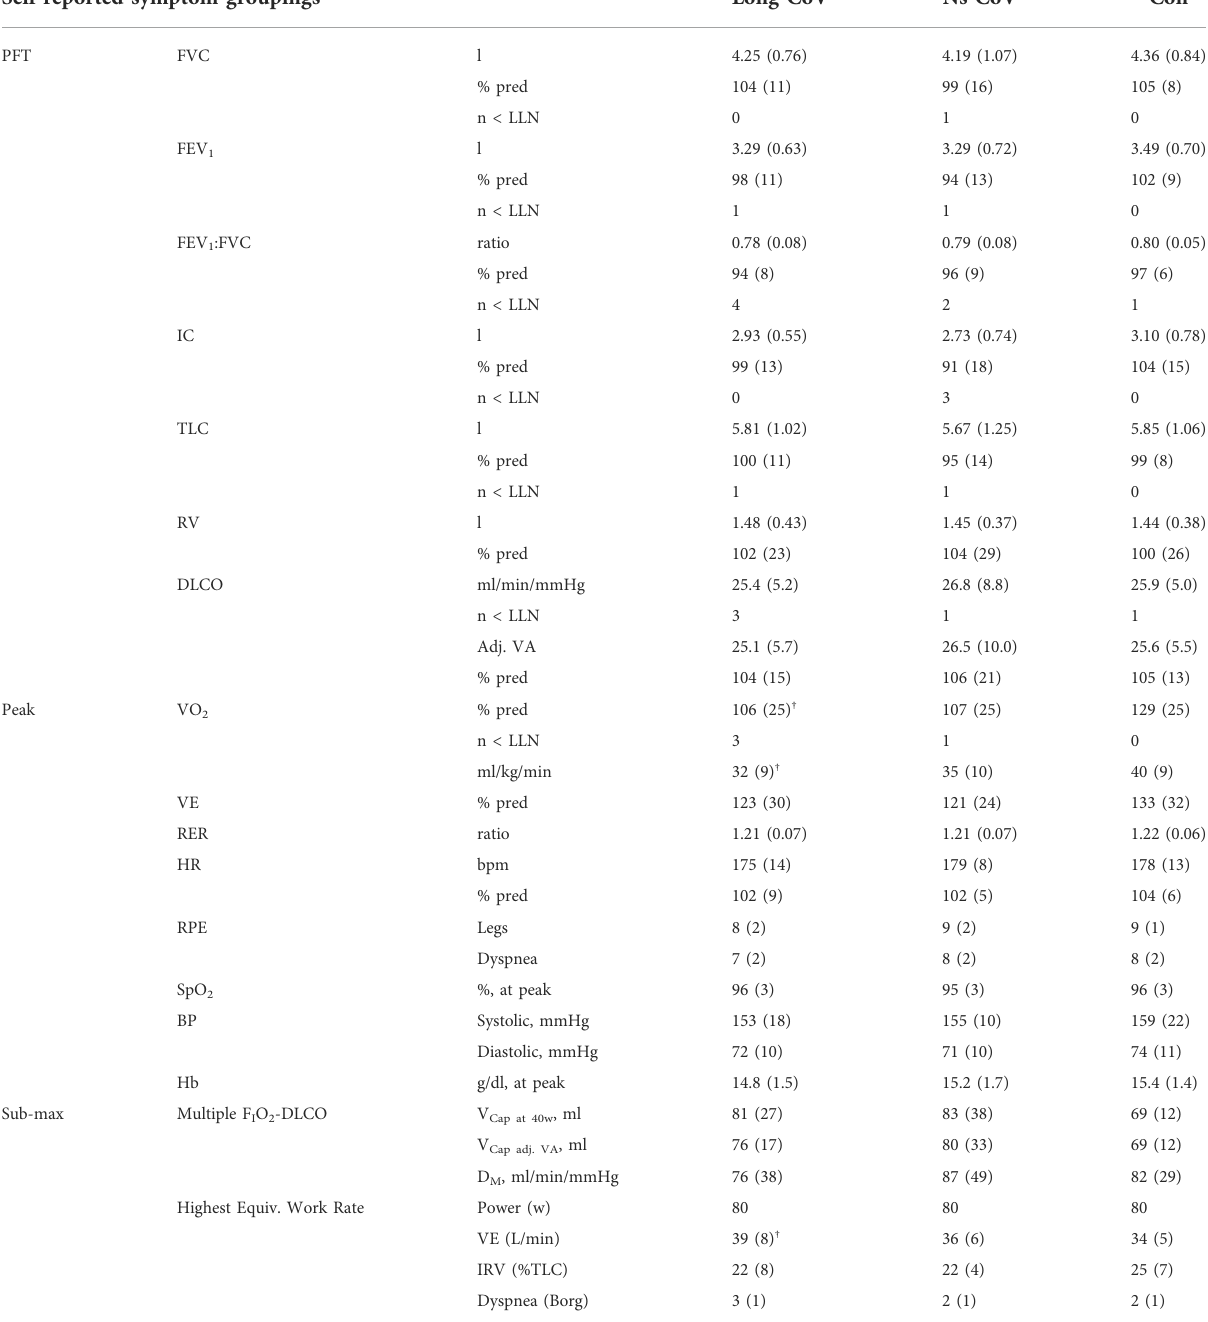
TABLE 3 Resting pulmonary function (pulmonary function test, PFT) and submaximal and peak exercise data for Long-CoV, no-longer symptomatic (ns)-CoV and Controls. Self-reported symptom groupings Long-CoV Ns-CoV